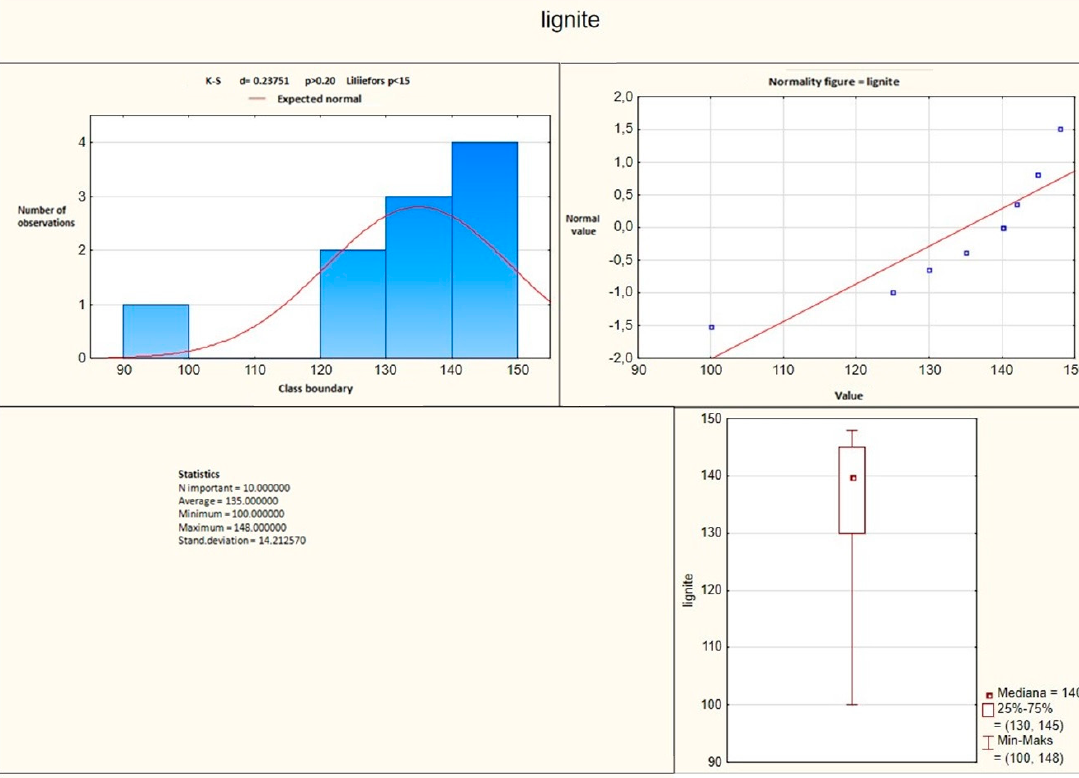
Figure 34. Statistical calculations for coal.